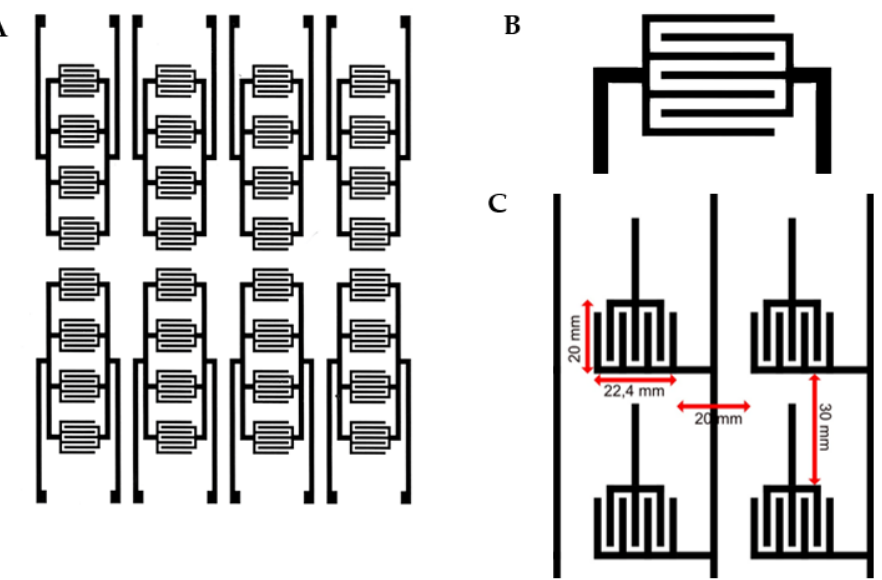
Figure 2. The pattern printed on the surface of the textile polyester base. ( A ) Macro view as it ap- pears on the material. ( B ) Detail of an individual active “cell”. ( C ) Details of sensor size and sensors’ spacing within the scheme. Each sensor works as a capacitor.